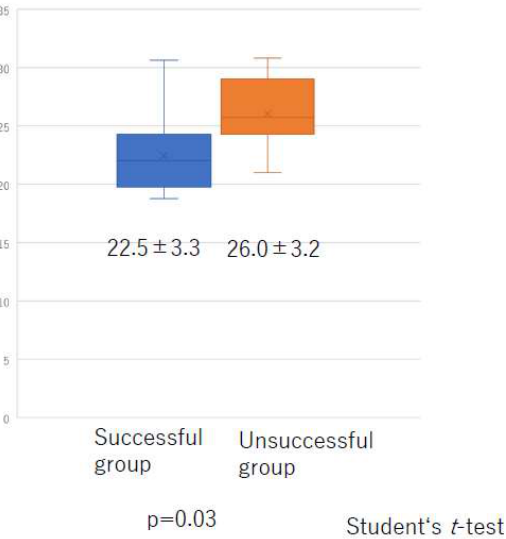
Figure 10. Body mass index according to whether liposuction was successful or unsuccessful.